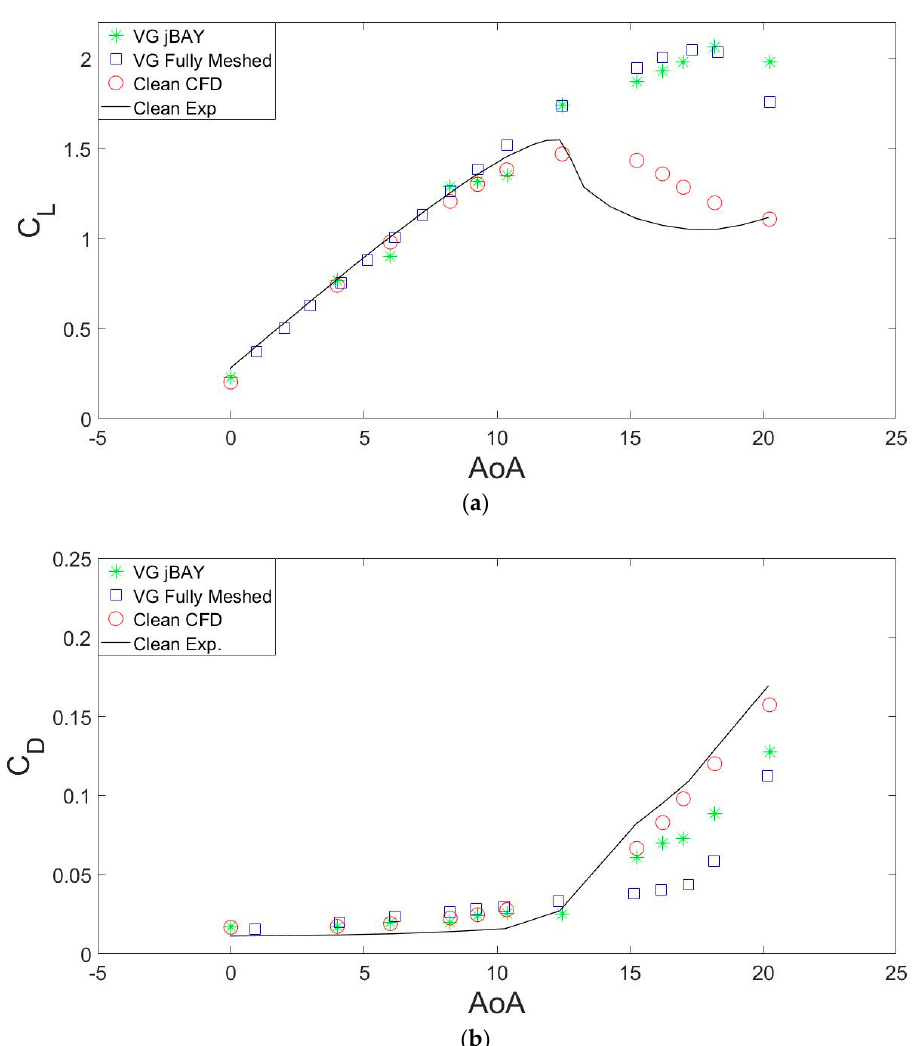
Figure 6. Comparison for DU97W300 and Re = 2 × 10 6 data of ( a ) lift coe ffi cient and ( b ) drag coe ffi cient between experimental and computational fluid dynamics (CFD) data.